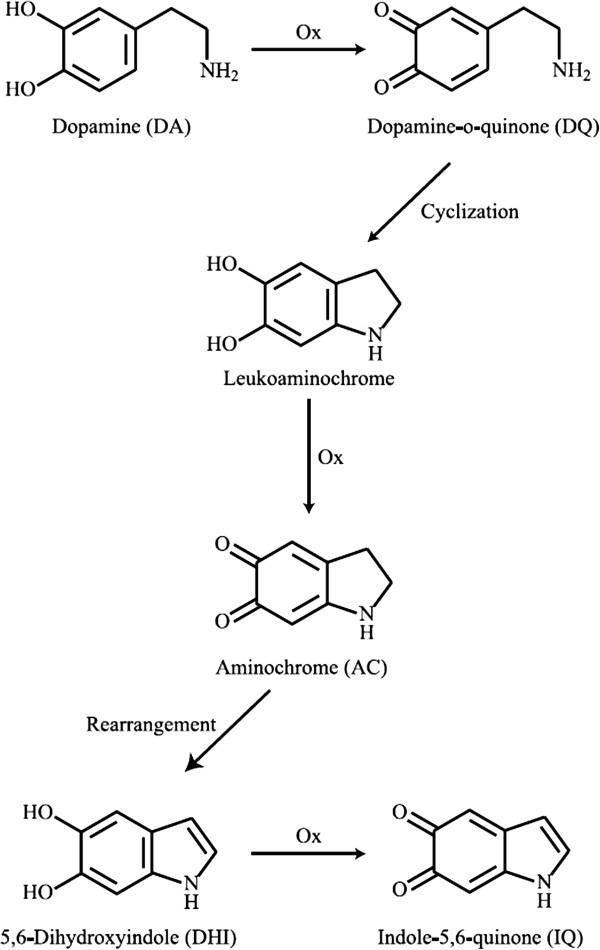
The oxidation pathway of dopamine[10].